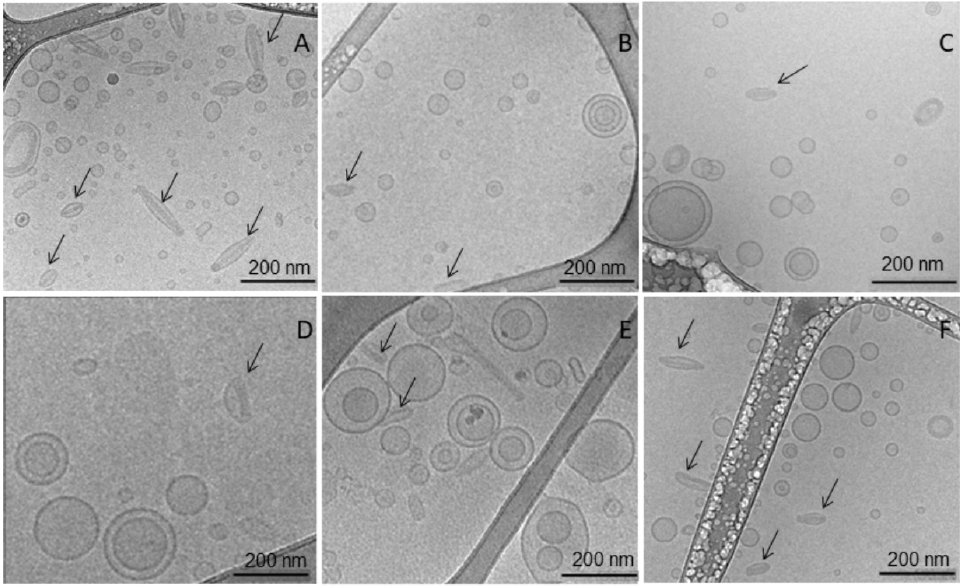
Figure 3. Cryomicroscopy images of the LCFL-PTX/DXR after freezing-thawing and freeze-drying processes. ( A ): Freshly prepared LCFL-PTX/DXR. ( B , C ): LCFL-PTX/DXR with trehalose 5:1 w / w and 9:1 w / w respectively, after freezing and thawing. ( D , E ): LCFL-PTX/DXR with trehalose 5:1 w / w and 9:1 w / w after fast freezing using N 2(l) . ( F ): LCFL-PTX/DXR sample containing trehalose 9:1 w / w after complete freeze-drying with cycle